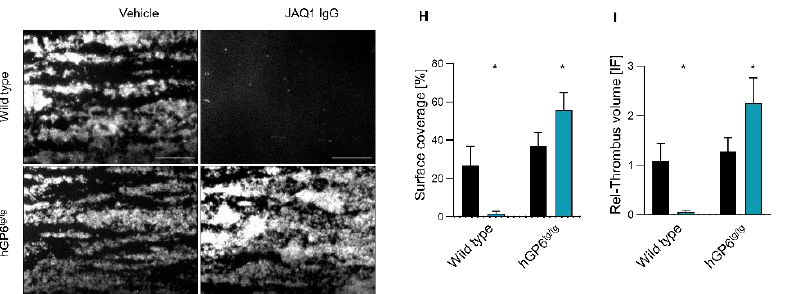
Figure 3. Differential effect of JAQ1 on huGPVI and mGPVI. ( A – D ) WT ( A , B ) or h GP6 tg/tg ( C , D ) diluted heparinized blood was pre-incubated with 20 µg/mL JAQ1 or control-IgG. Treated platelets were incubated with WUG 1.9-FITC ( A , C ), JON/A-PE ( B , D ) and stimulated with CRP (10 µg/mL), convulxin (1.25 µg/mL) or vehicle; ( E , F ) Washed platelets from WT ( E ) or h GP6 tg/tg ( F ) were pre-incubated with 20 µg/mL JAQ1 or control IgG and aggregation was induced with the indicated agonists; aggregation was measured for 10 min; ( G – I ) Heparinized WT or h GP6 tg/tg blood was pre-incubated with 20 µg/mL JAQ1 or control IgG and tested in flow adhesion assay on a collagen-coated surface. Percentage of the covered surface ( H ) and relative volume of thrombi ( I ) were analyzed based on fluorescence intensity of anti-GPIX-AF488 derivative. Experiments shown are representative of n = 4. Flow cytometry data are expressed as means ± SD, significance is expressed as * p < 0.05, ** p < 0.01, *** p < 0.001 vs. indicated group ( t- test).